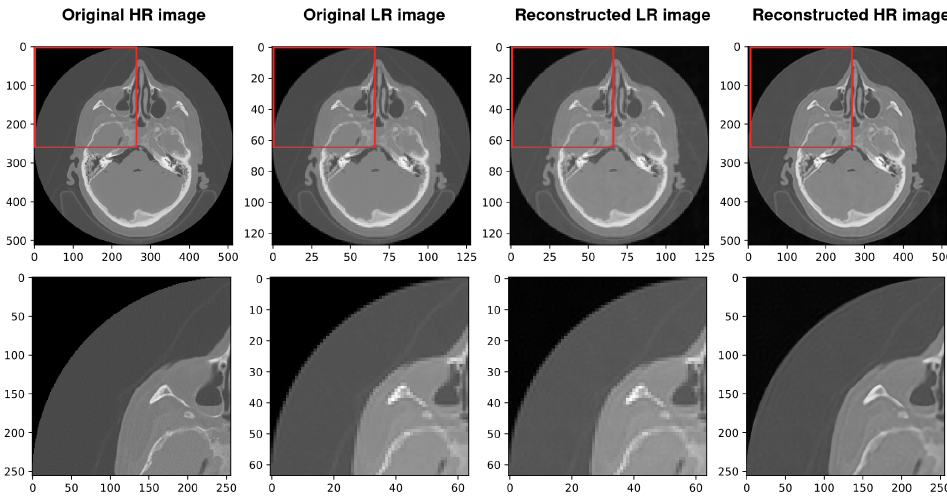
Figure 7. Results of the whole procedure of our architecture. From the left, the first image shows the original high-resolution (HR) image. The second image shows the original low resolution (LR). The third image shows the reconstructed low resolution (LR) and the last shows the reconstructed high resolution (HR). The best PSNR of reconstructed HR in comparison with the original HR is